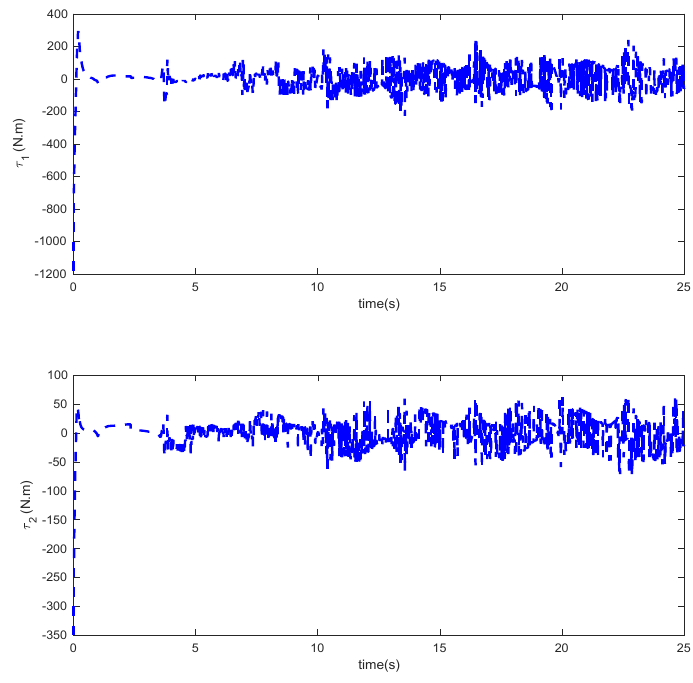
Figure 5. Control input in Scenario 1.